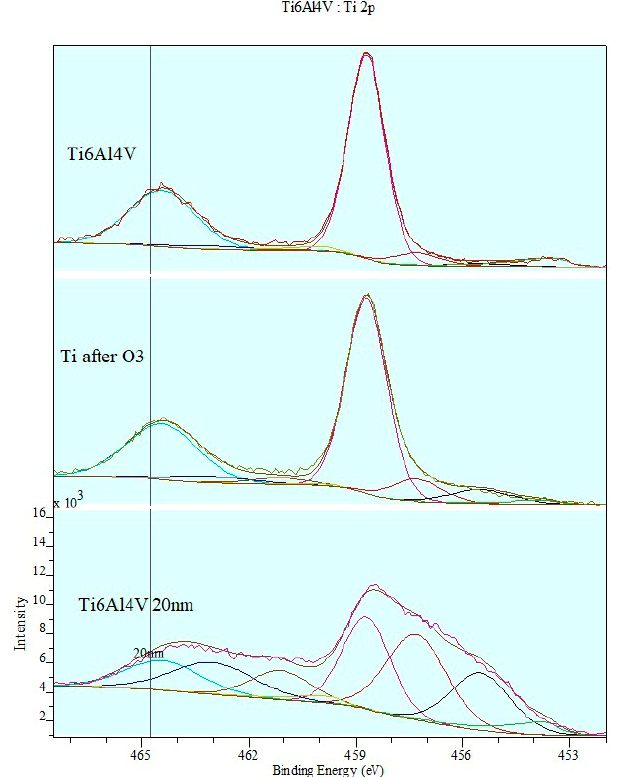
Figure 7. Changes in doublets at valence band in Ti2p spectrum.